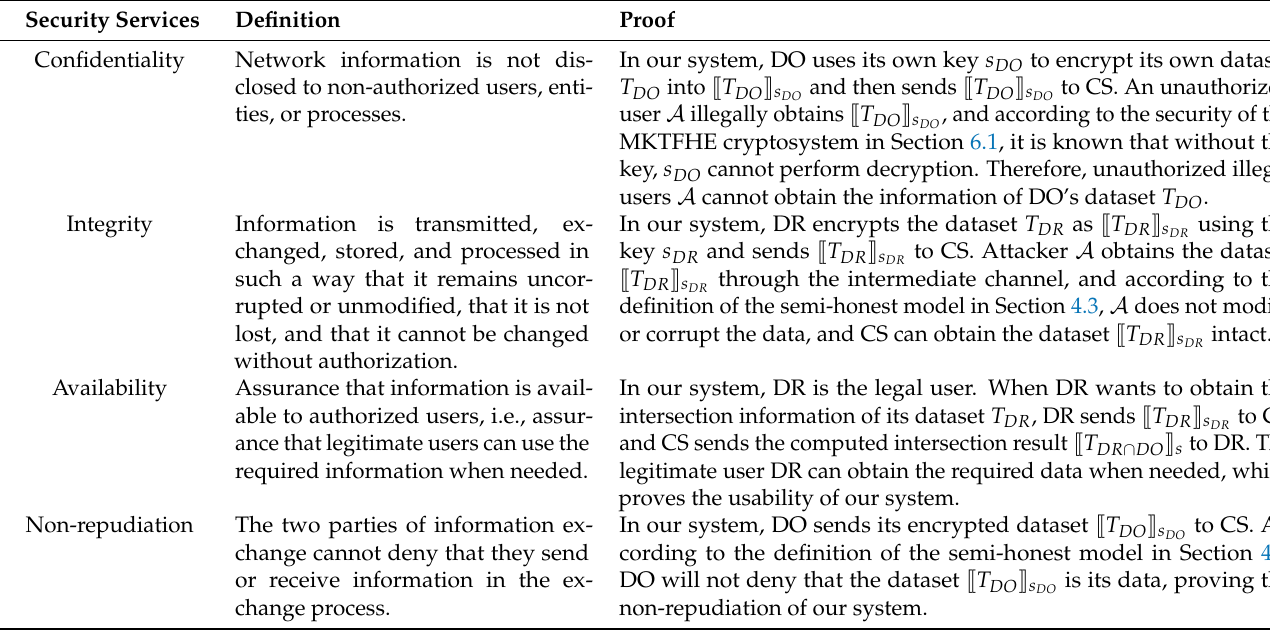
Table 3. Security services provided.